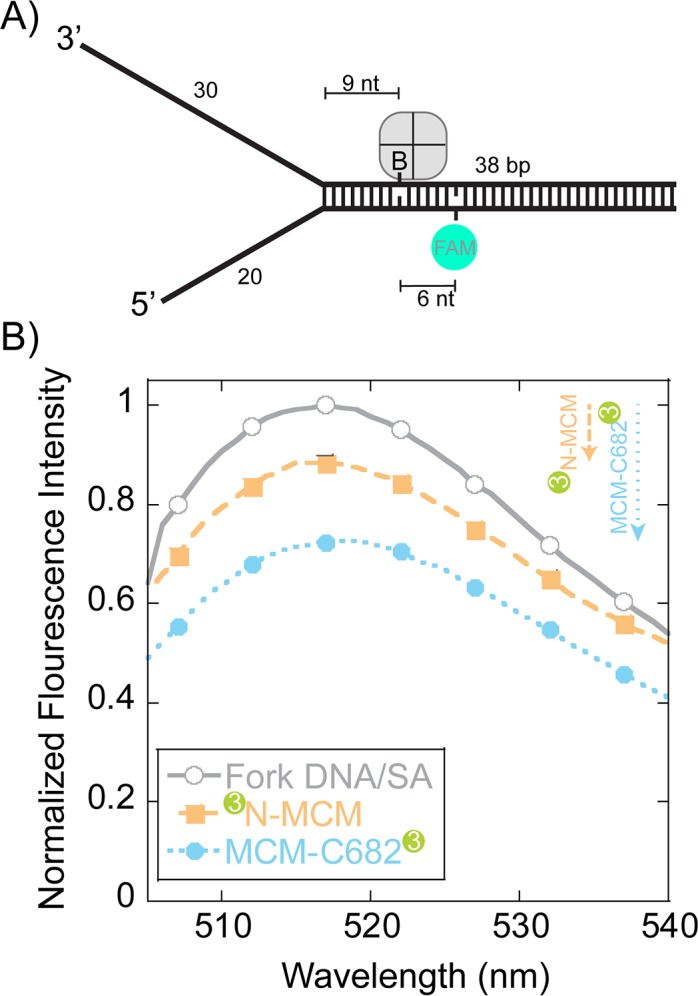
Steady-state FRET quenching of SsoMCM bound to a fork DNA.(A) Schematic of the DNA fork substrate that includes a 30 nt 3’-arm, 20 nt 5’-arm, a biotin placed nine nt from the duplex junction and a dT-FAM placed a further six nt downstream. The Tm of the duplex was calculated to be greater than 75°C. (B) Normalized FAM quenching effects upon addition of SsoMCM labelled with Cy3 at the N-terminus (closed boxes, orange) or C682 (closed circles, blue). Background changes in fluorescence upon addition of unlabelled SsoMCM were subtracted prior to normalization.